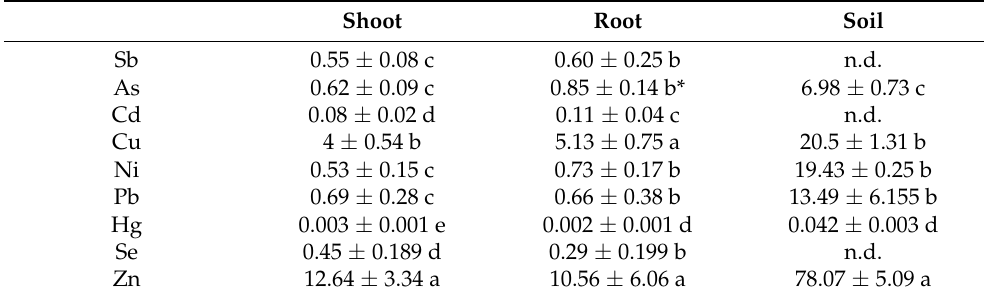
Table 1. Determination of selected PTEs in aerial biomass, underground biomass and in the soil